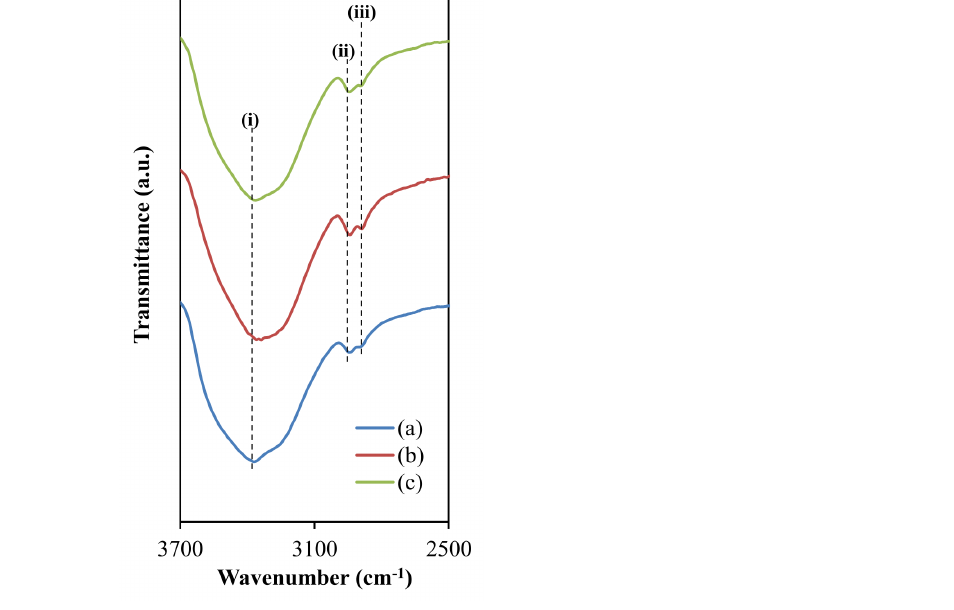
Figure 2. FTIR spectra at a wave number between 2500 and 3700 cm − 1 for ( a ) CDLG–1, CDLG–2, and CDLG–3 plasticized electrolyte